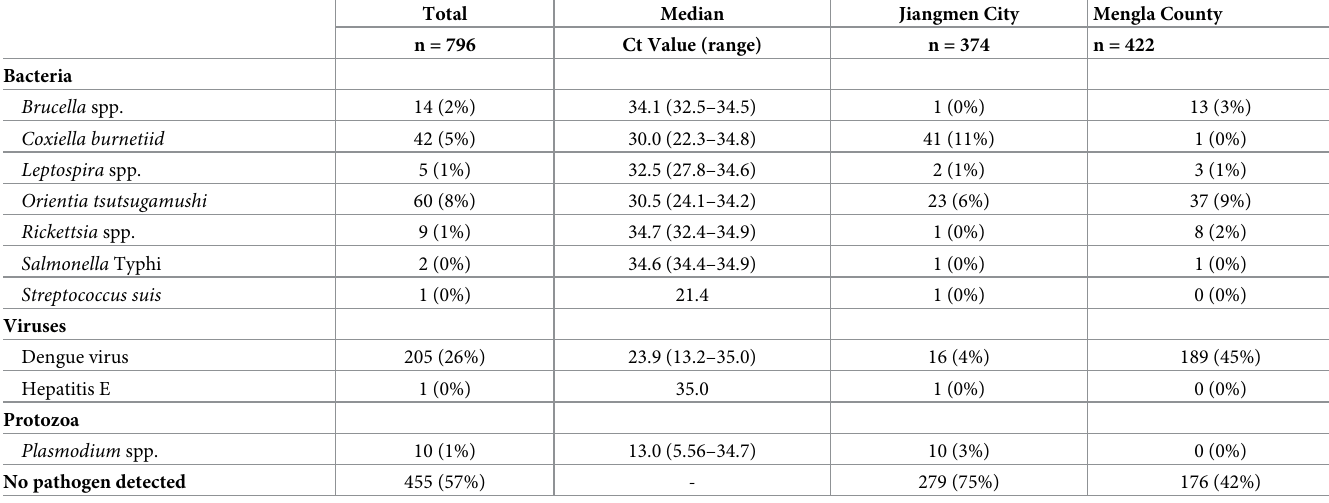
Table 3. TaqMan Array Card (TAC) diagnostic test results � and cycle threshold values (Ct) for patients enrolled in the acute febrile illness surveillance project by location in China, June 2017–July